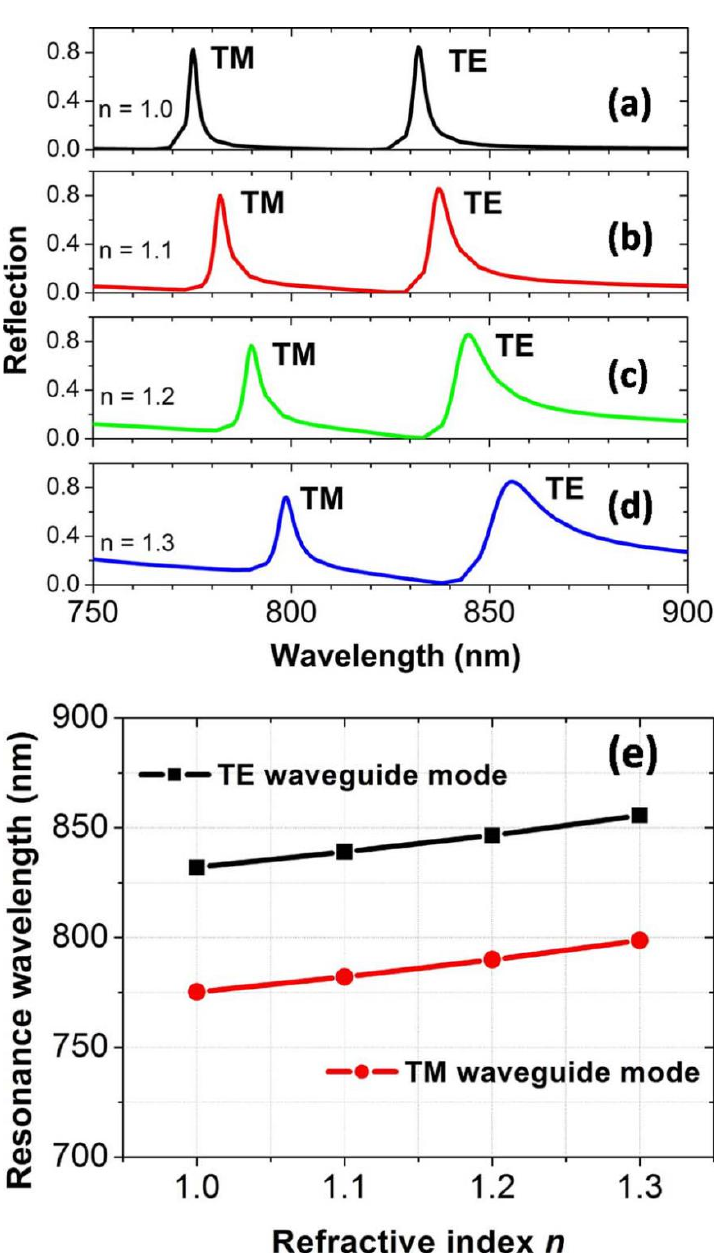
Figure 6. ( a – d ) The reflection spectra at normal incidence for a different refractive index. ( e ) The dependence of the reflection peak on the refractive index.